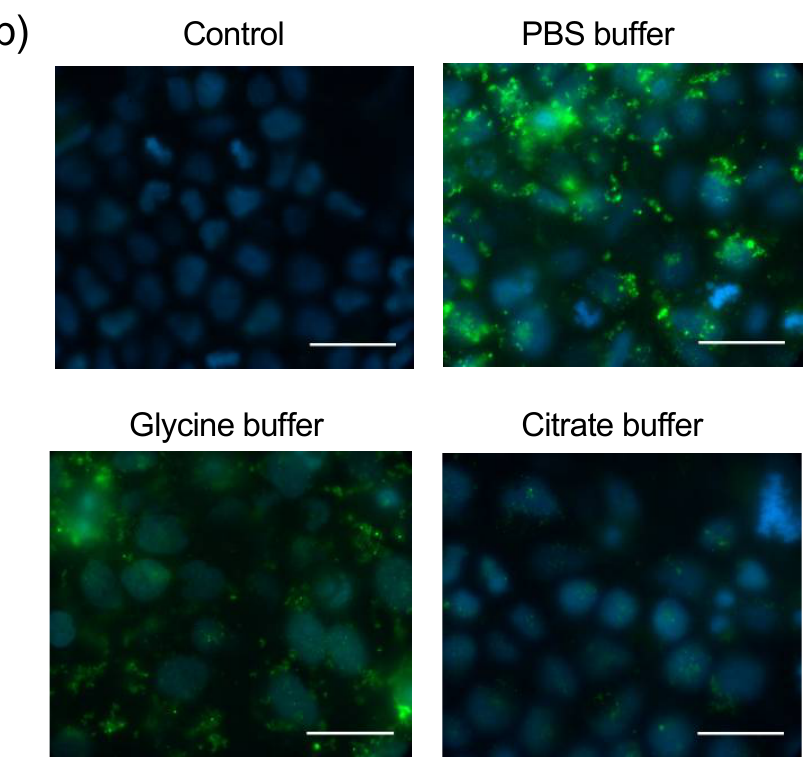
Figure 2. The importance of choosing an e ffi cient bu ff er for cell washing. ( a ) Quantitative measurements